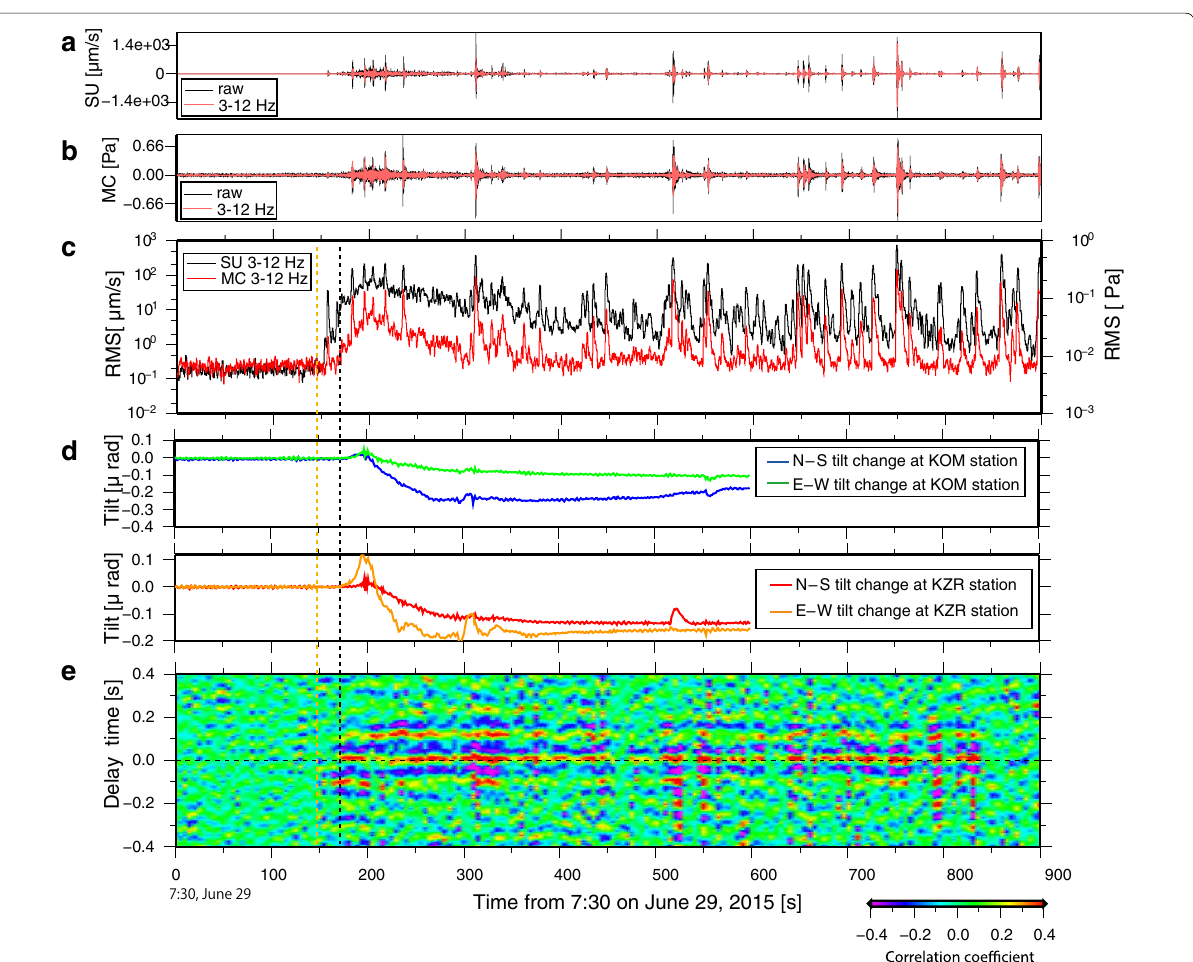
Fig. 3 Seismic and microphone records at the OWD station during the rapid tilt change. The raw and band-passed signals of a a seismometer (vertical component) and b a microphone. c RMS amplitude during a 1-s moving window of the band-passed signals. d Time sequence of the tilt- meters at the KOM and KZR stations. e The microphone–seismometer correlation function with a 5-s moving window. The yellow and black broken lines show the onset of the seismic RMS amplitude and the rapid tilt change,